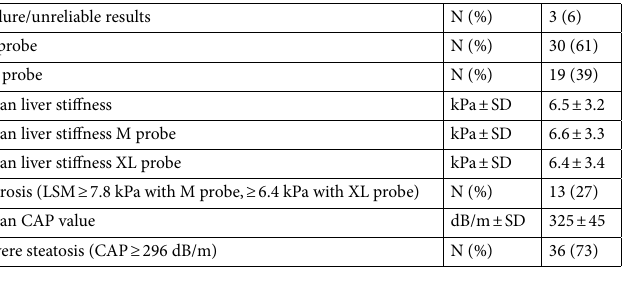
Table 2. Transient elastography results. LSM liver stiffness measurement, CAP controlled attenuation